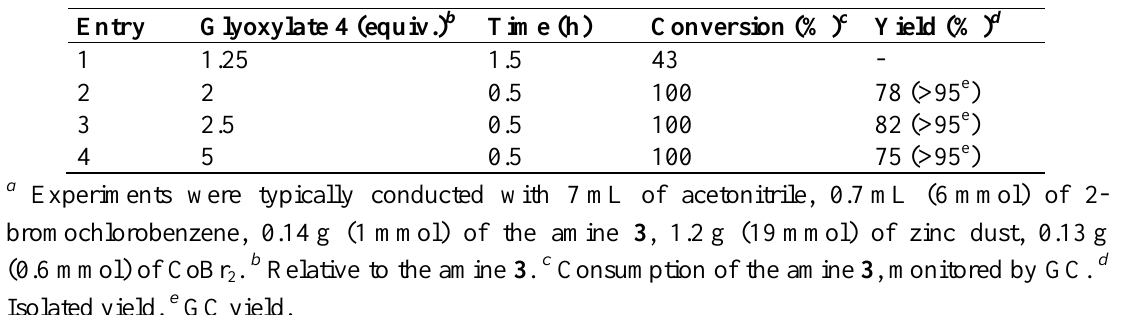
Table 2. Influence of glyoxylate amount.